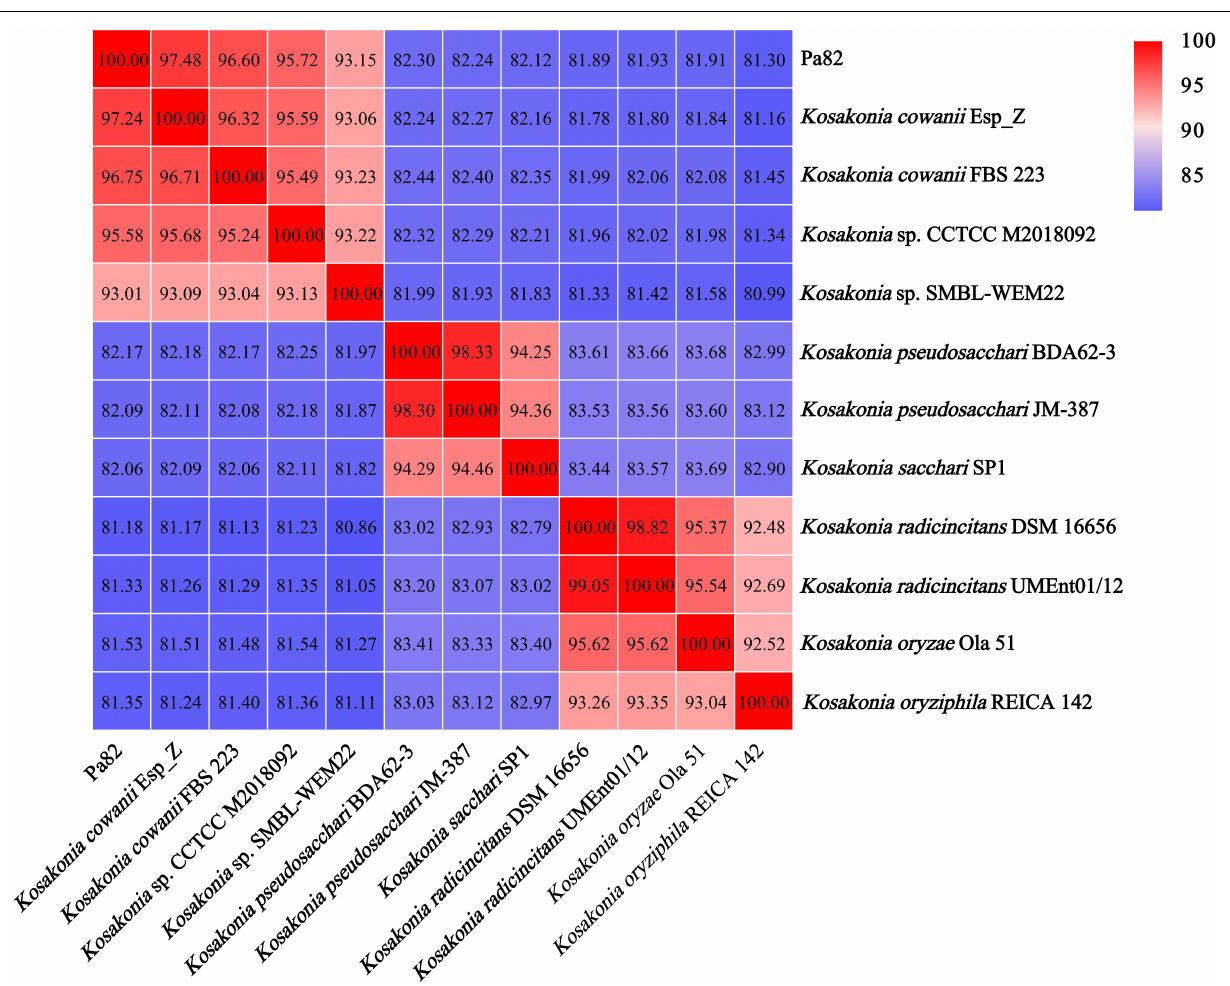
Table 3 . These genes are classified into 6 categories,